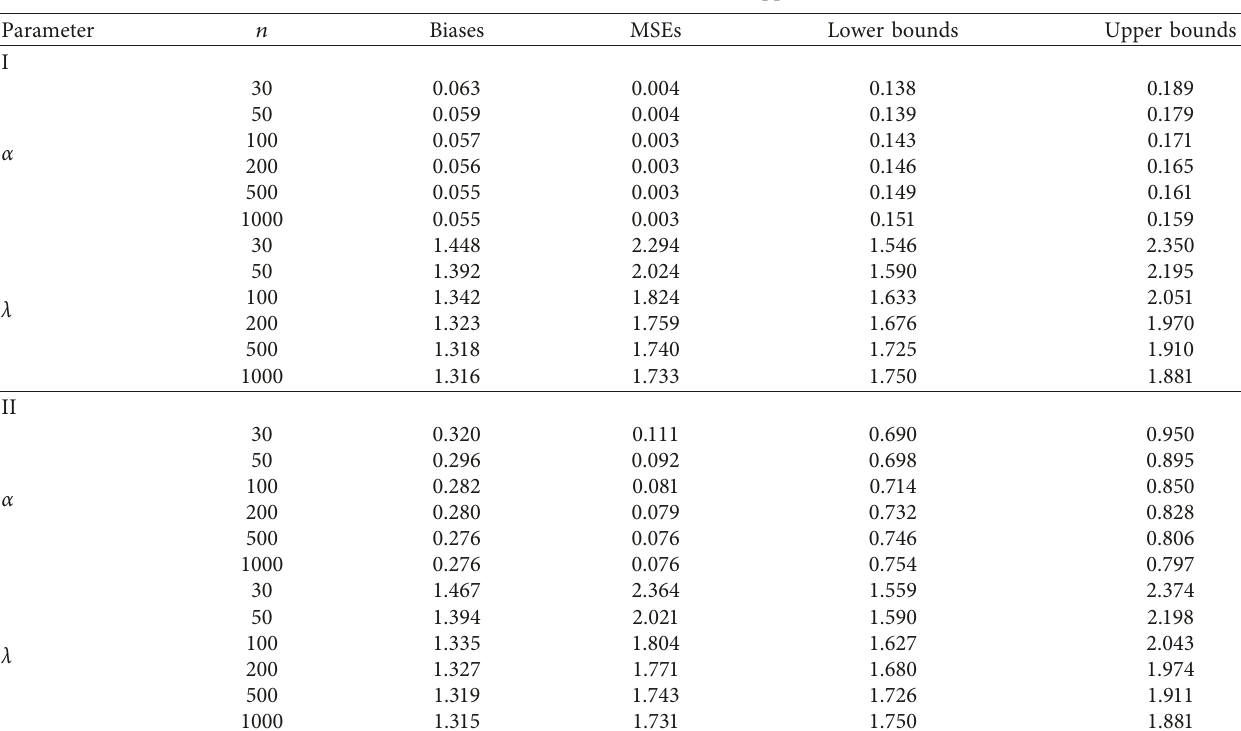
Table 3: MSEs, biases, lower bounds, and upper bounds.